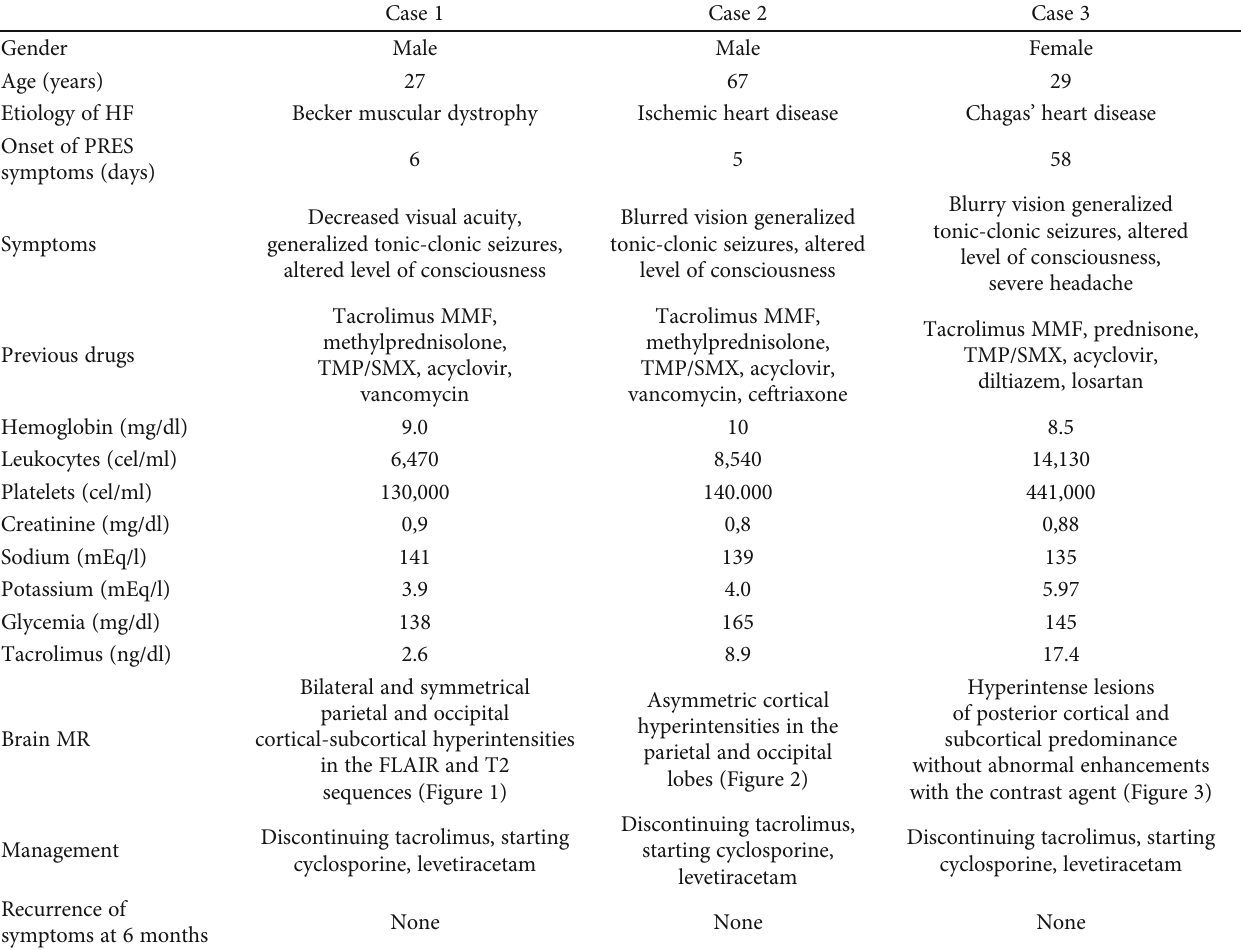
Table 1: Description of patients with PRES after heart